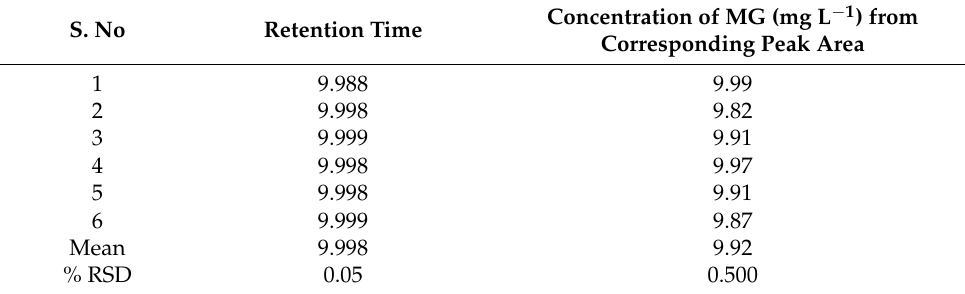
Table 2. System suitability data for the MG.